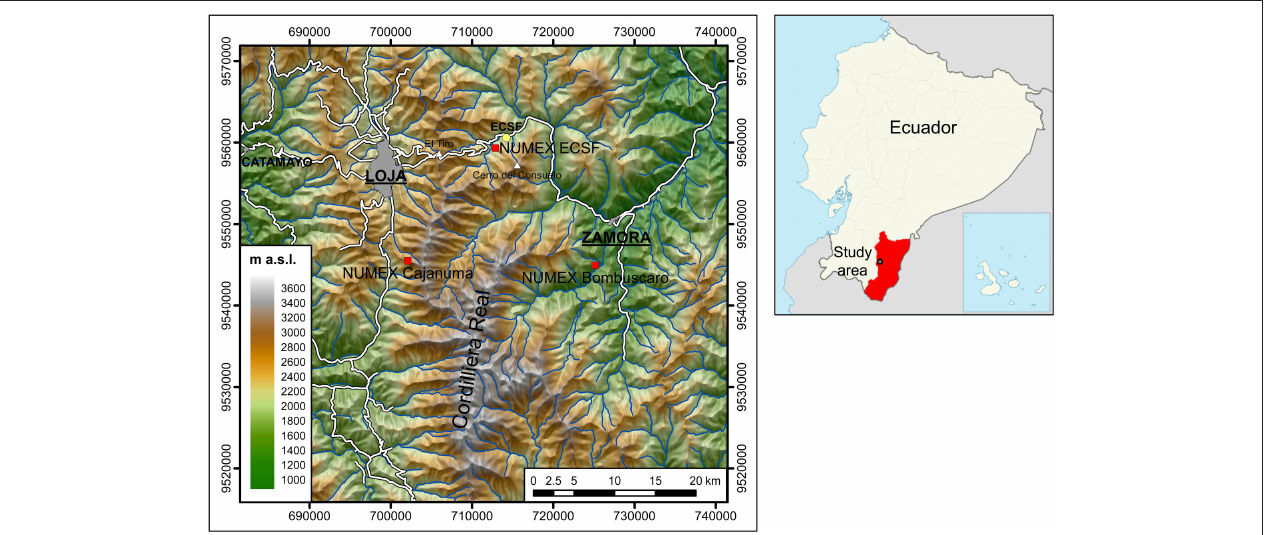
FIGURE 1 | Location of the research area and of the Nutrient Manipulation Experiment (NUMEX). Our study focuses on the experimental site at 2000m a.s.l. near the Research Station San Francisco (ECSF). Coordinate system: WGS84, UTM Zone 17 M. Cartographic data: Instituto Geográfico Militar (2013).